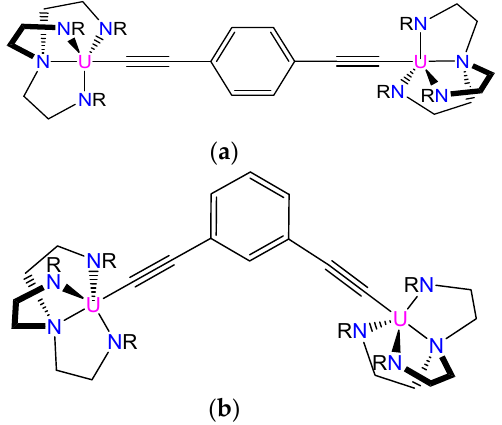
Figure 9. Molecular structures of the para- ( a ) and meta-diuranium(IV) ( b ) [(NN ′ 3 ) 2 U 2 (DEB)] [107].